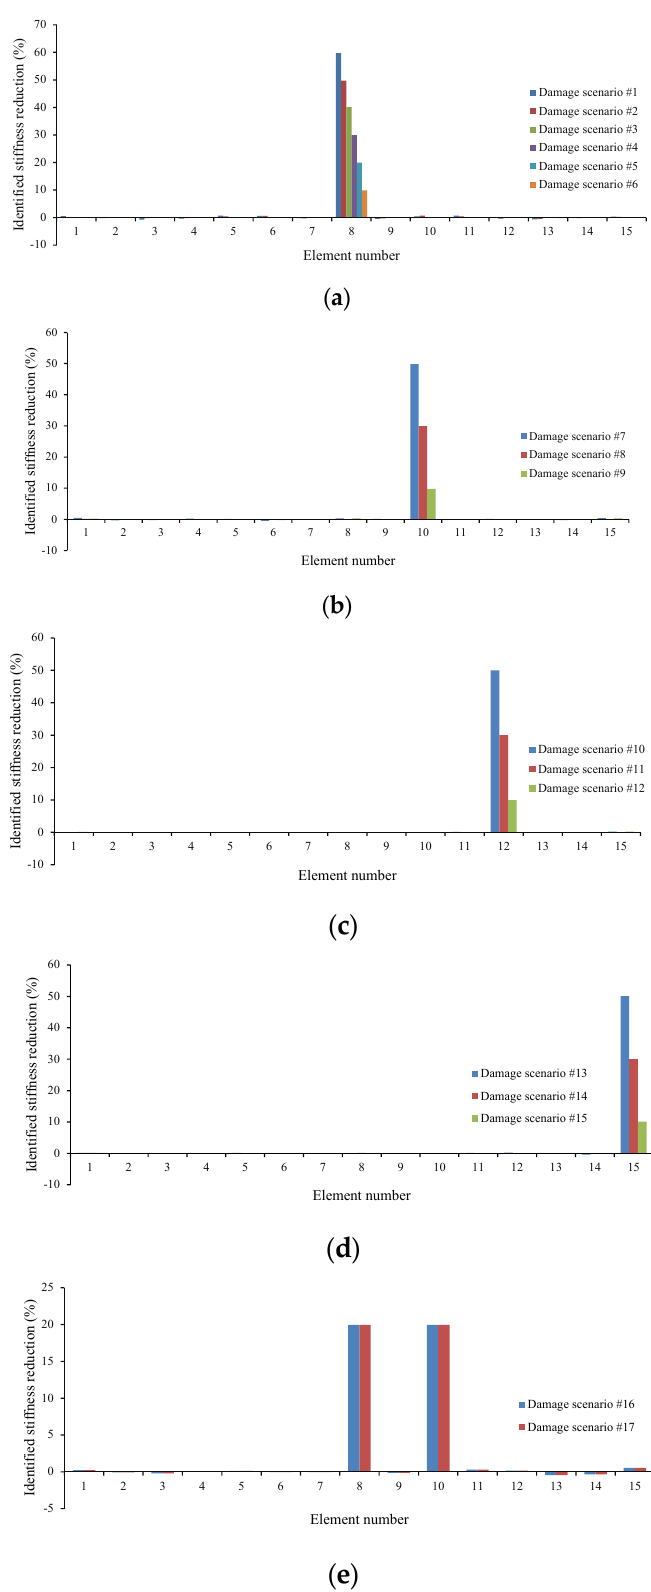
Figure 1. Accuracy of the method for damage scenarios 1–17. ( a ) Element 8; ( b ) Element 10; ( c ) Element 12; ( d ) Element 15; ( e ) Elements 8 and 10. Table 3. Different damage scenarios.